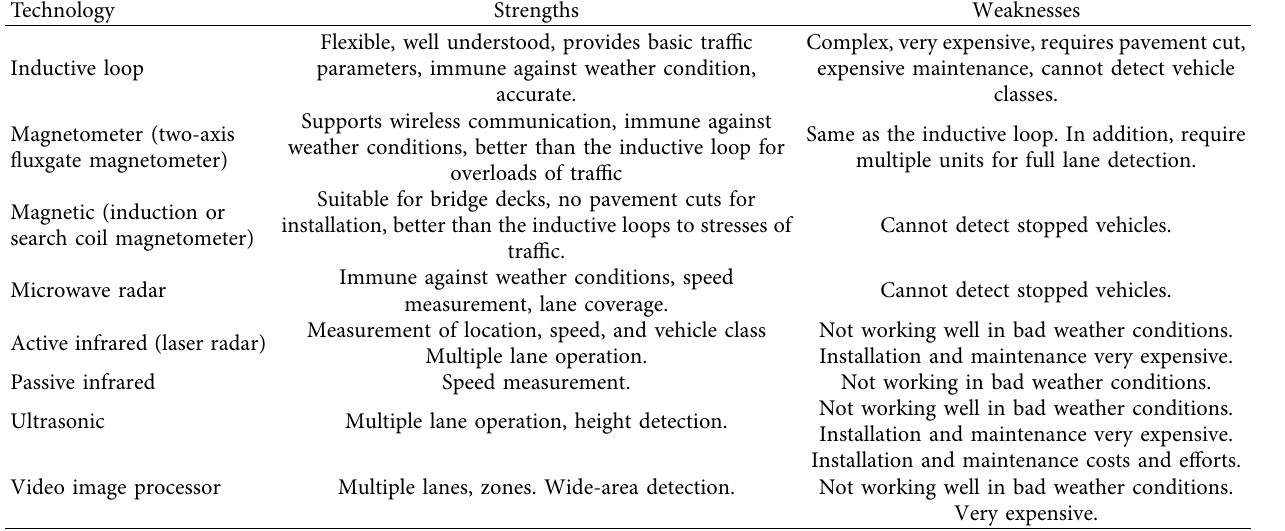
Table 1: Strengths and weaknesses of commercially available sensor technologies [11].